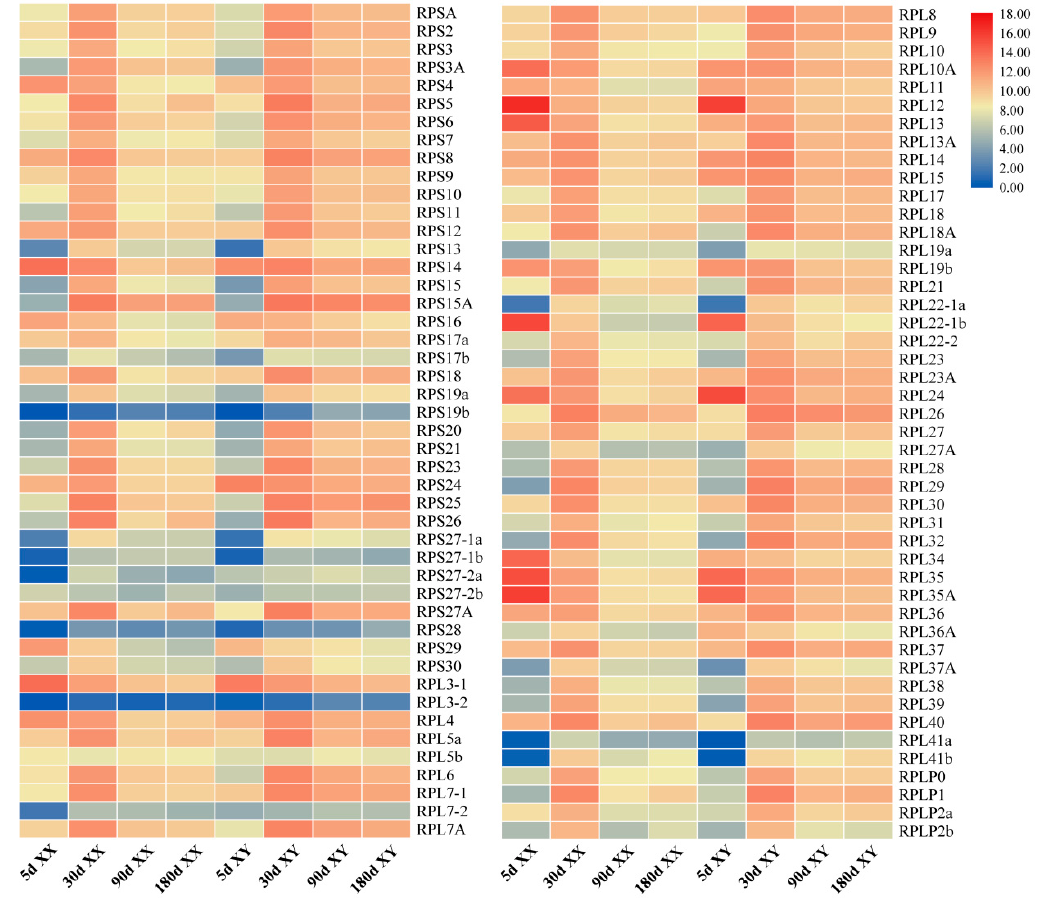
Figure 6. The expression profiles of RP genes in XX and XY gonads based on transcriptome data from tilapia. RNA preparations from gonads of XX and XY fish at 5, 30, 90 and 180 dah (day after hatching) were sequenced previously [30]. RPKM (reads per kb per million reads) was used to normalize the expression profiles of RP genes. Int. J. Mol. Sci. 2019 , 20 , x FOR PEER REVIEW Table 2. Statistics of RP gene expressions in tilapia gonads at four developmental stages.